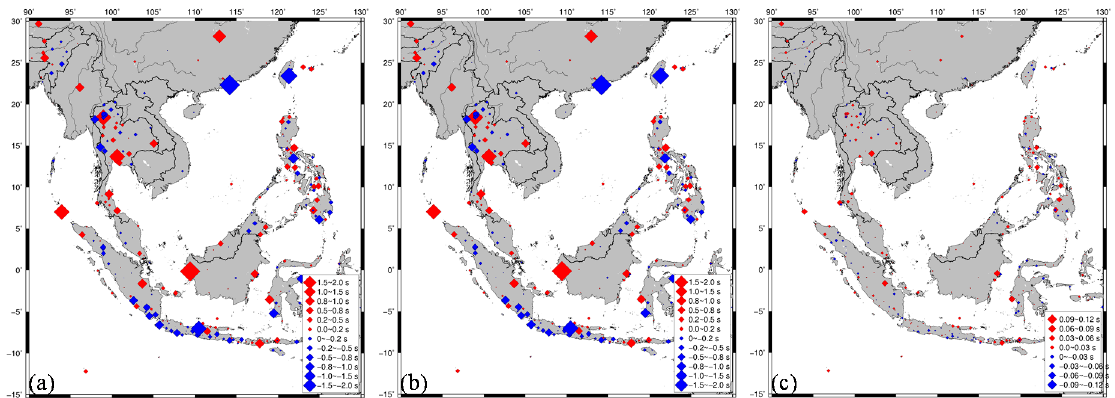
Figure 8. ( a ) Distribution of average relative travel time residuals at each station before crust correction. ( b ) Distribution of average relative travel time residuals at each station after crust correction. ( c ) Distribution of the change of average relative travel time residuals at each station after crust correction.